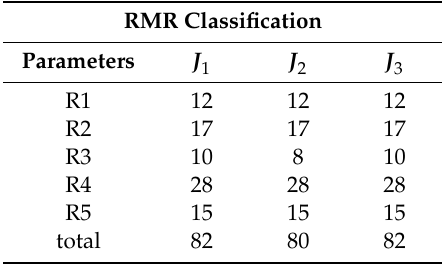
Table 1. Assigned parameters of the discontinuity sets used for the estimation of the RMR